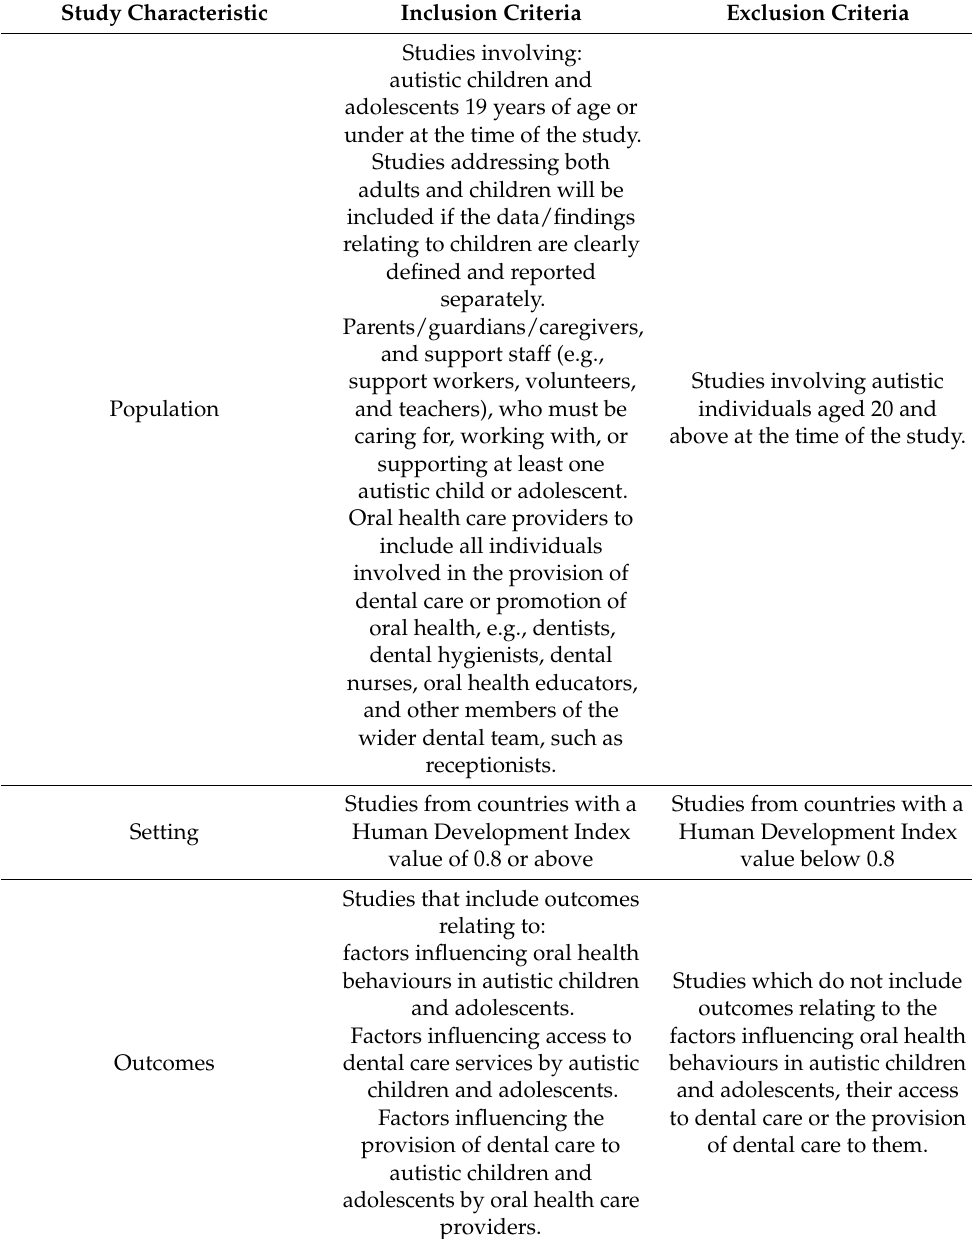
Table 1. Summary of Inclusion and Exclusion